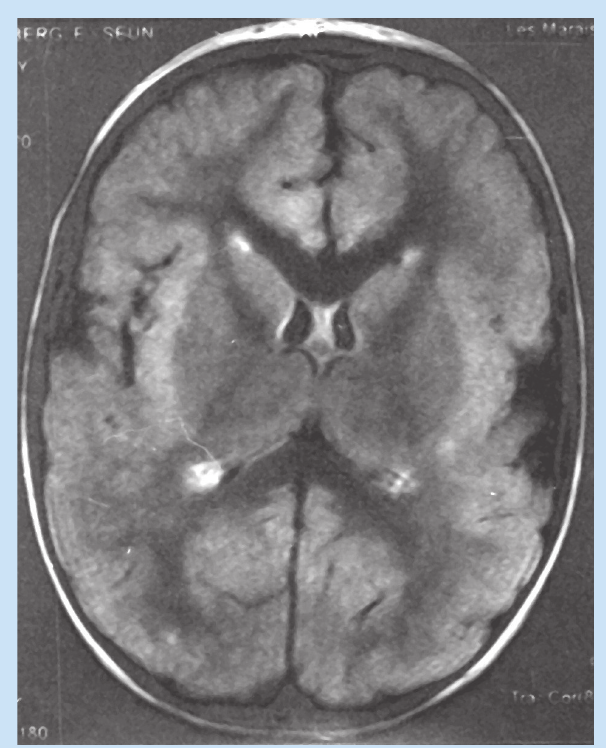
Fig.1. Axial FLAIR sequence. Note the cortical defect in the perisylvian region, more prominent on the left side.